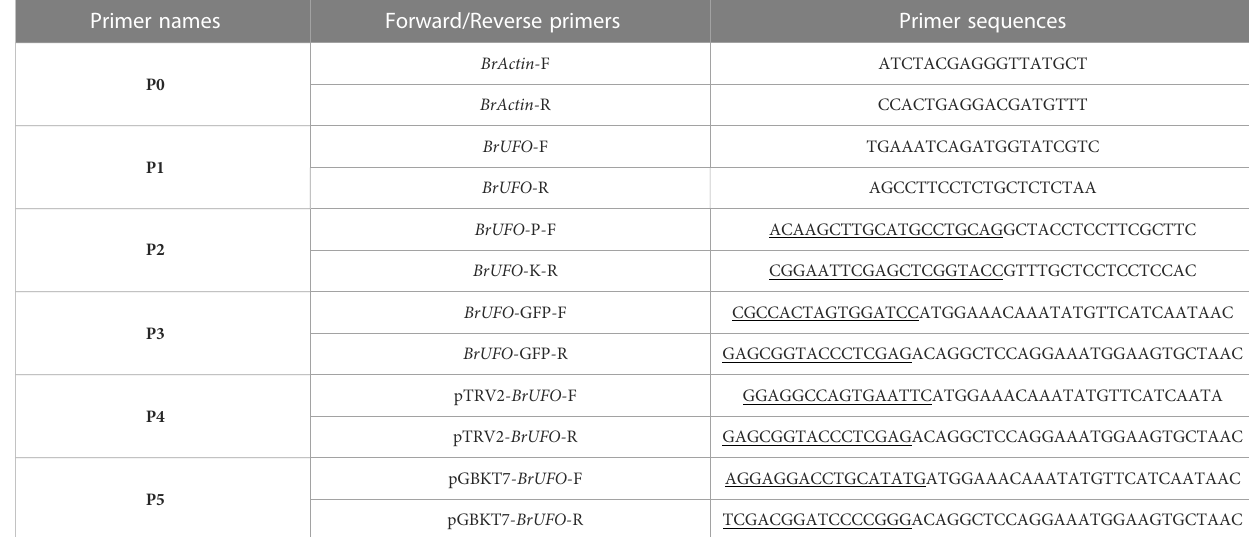
TABLE 1 Primer sequences related to BrUFO